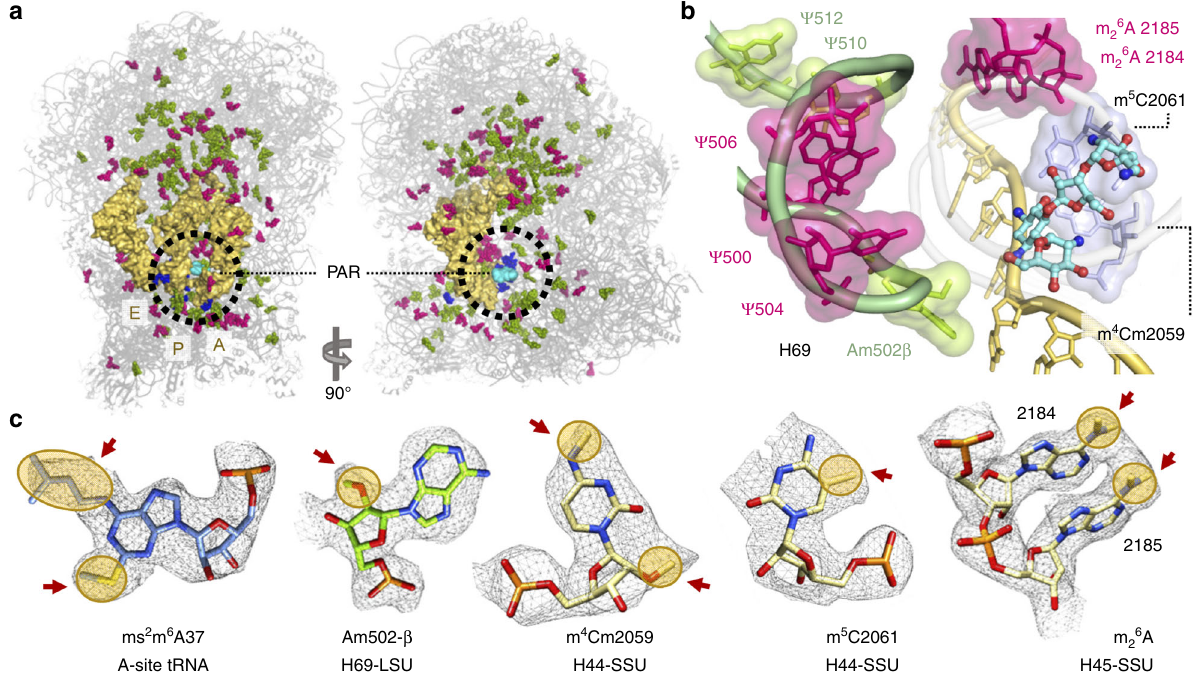
Fig. 3 RNA modi fi cations reveal an unexpected pattern of mixed bacterial and eukaryotic origins. a The high-resolution structure obtained in this study enabled the direct visualization of rRNA modi fi cations in the leishmanial ribosome, many of which are localized at the decoding center (circled) in close proximity to the PAR binding pocket. 2 ′ - O -methylated residues are highlighted in green, pseudouridines in magenta and unique base modi fi cations are colored blue. b The PAR-binding pocket at the leishmanial ribosome is decorated with modi fi ed residues that are of mixed bacterial and eukaryotic origin. Modi fi cations of bacterial origin (light blue) at h44 of SSU are clustered with two universally conserved modi fi cations at h45 (magenta), to form a bridge that connects elements of the decoding center with mRNA A-site codon (yellow). H69 (light green) of LSU is also heavily modi fi ed and penetrates the PAR binding pocket. Leishmania H69 modi fi cations of eukaryotic origin are highlighted in green, and universally conserved modi fi cations in magenta. c rRNA modi fi cations in the binding pocket. Densities are shown at 3.0 σ . Modi fi ed moieties are indicated by arrow and highlighted in